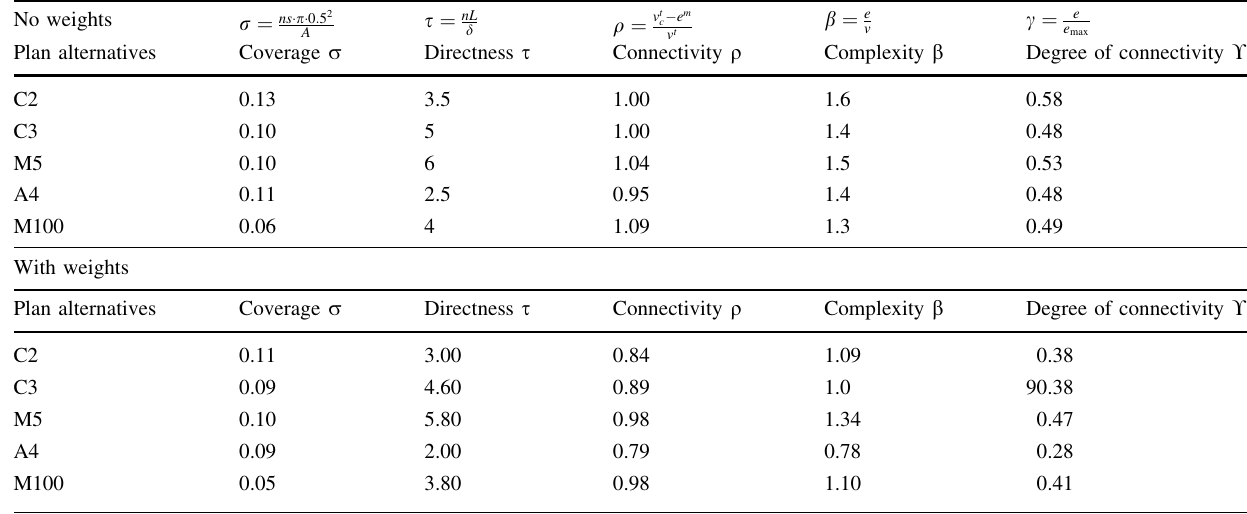
Table 5 Network measures of the proposed Tel Aviv mass transit alternatives—original measures (no weights) and measures modified to represent LRT lines (with weights) No